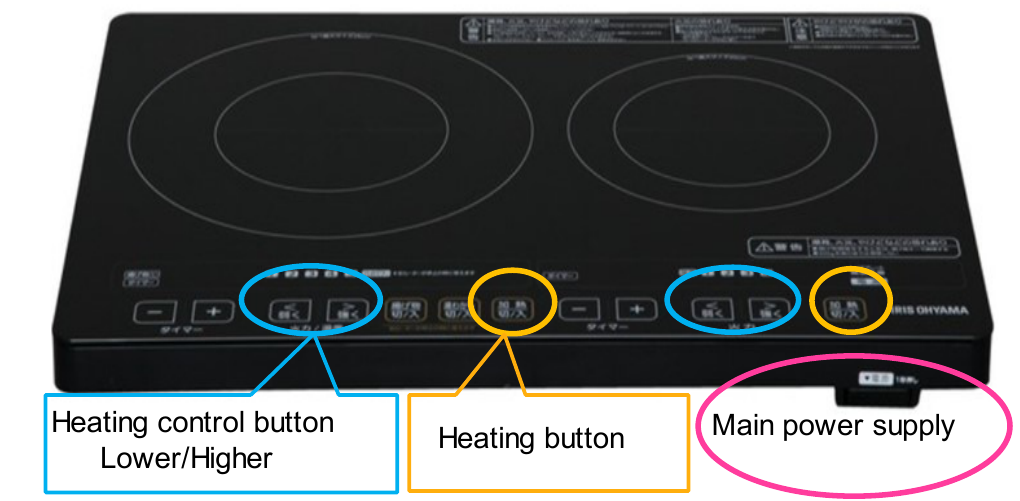
Figure 1. IH cooker used in the